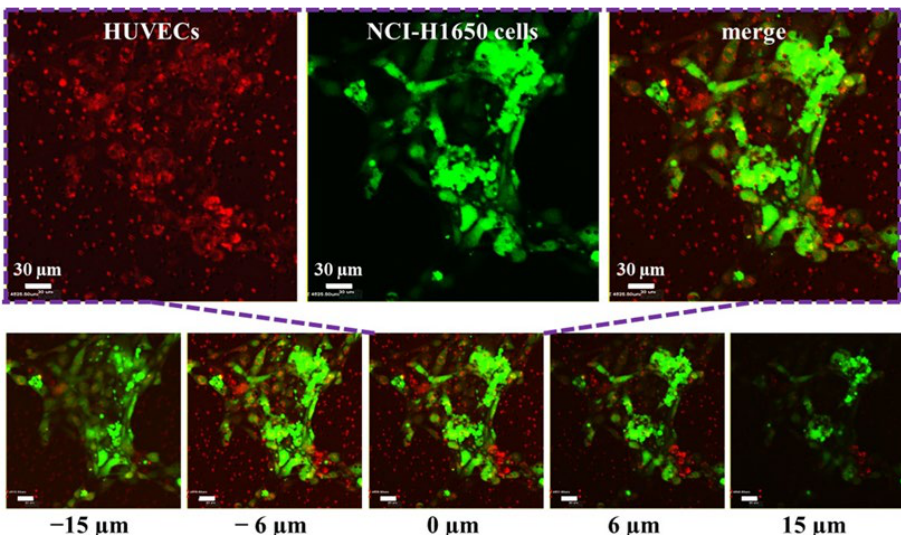
Figure 3. Fluorescence images of HUVECs and NCI-H1650 cells stratified co-cultured on both sides of the microporous membrane. HUVECs (red) were labeled by Cell Tracker Red CMTPX and NCI-H1650 cells (green) were labeled by Cell Tracker Green CMFDA. Scale bars = 30 µ m. We defined the z-axis position of the microporous membrane as 0 µ m. The indicated distances are measured from the membrane plane (0 µ m). The positive values are above it, while the negatives are below.